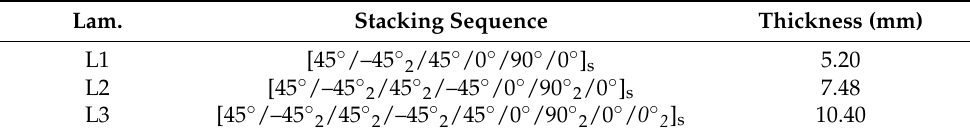
Table 7. Plies arrangements for the stacking sequences evaluated in the local FE model.